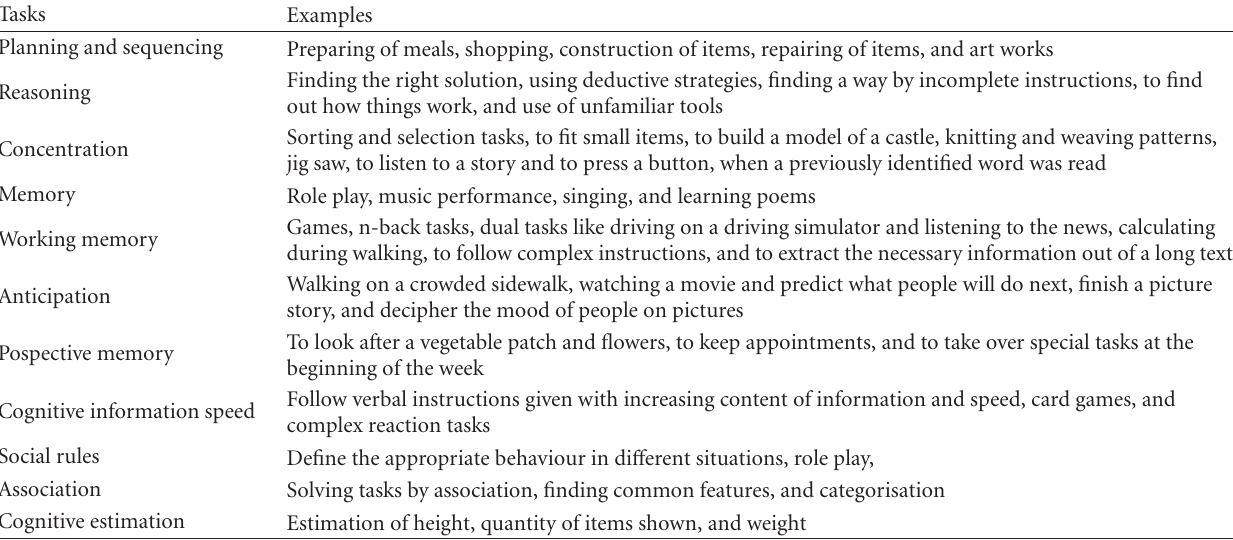
Table 2: Transfer